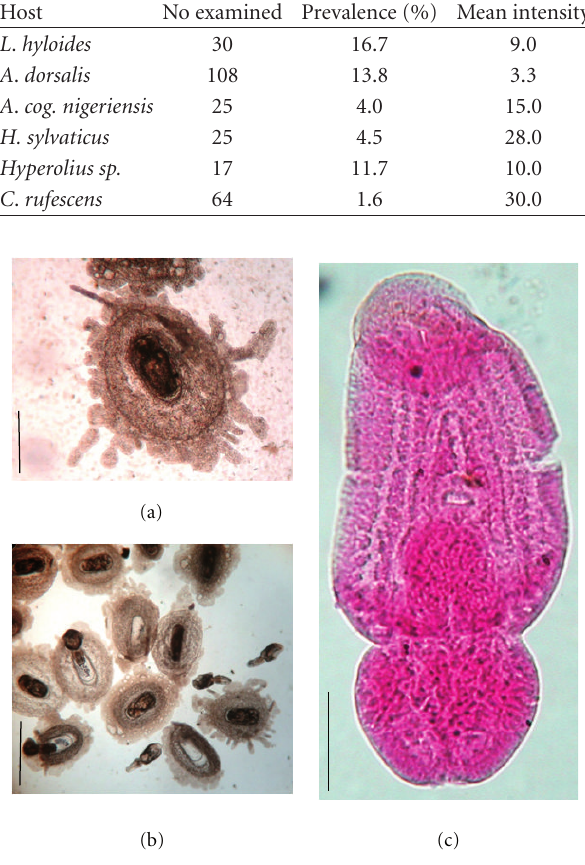
Figure 1: Strigeoid trematode recovered from the body cavity of some tree frogs at the Okomu National Park. (a), Unexcysted metacercariae; (b), metacercariae in the excystment medium; (c), stained specimen of the excysted juvenile parasite. Scale bar: A = 200 µ m, B = 500 µ m, C = 50 µ m. Table 2: Prevalence of nematode larvae type 1 in anurans at the Okomu National